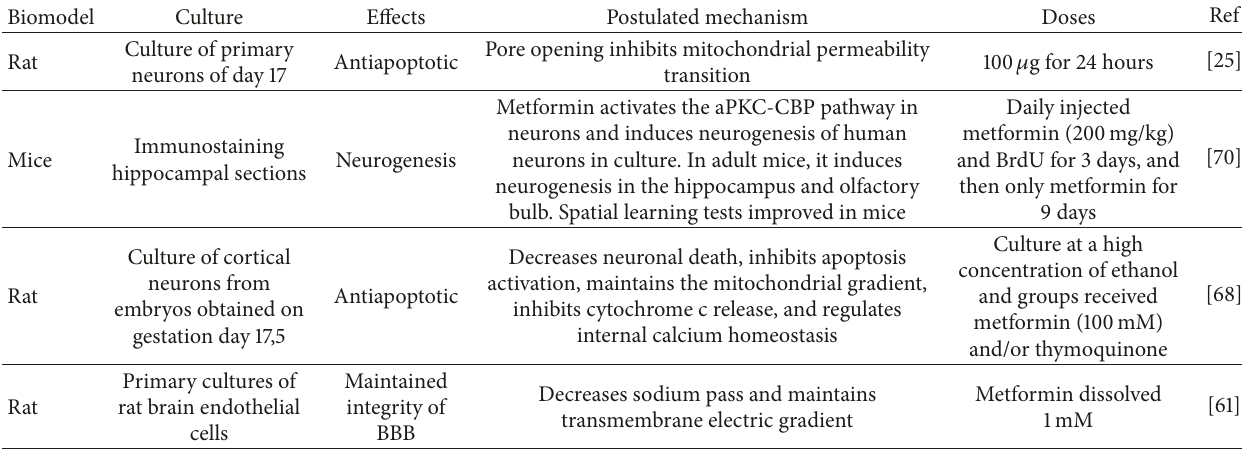
Table 1: Different cellular pathways studied on cultured neurons using metformin in vitro/in vivo